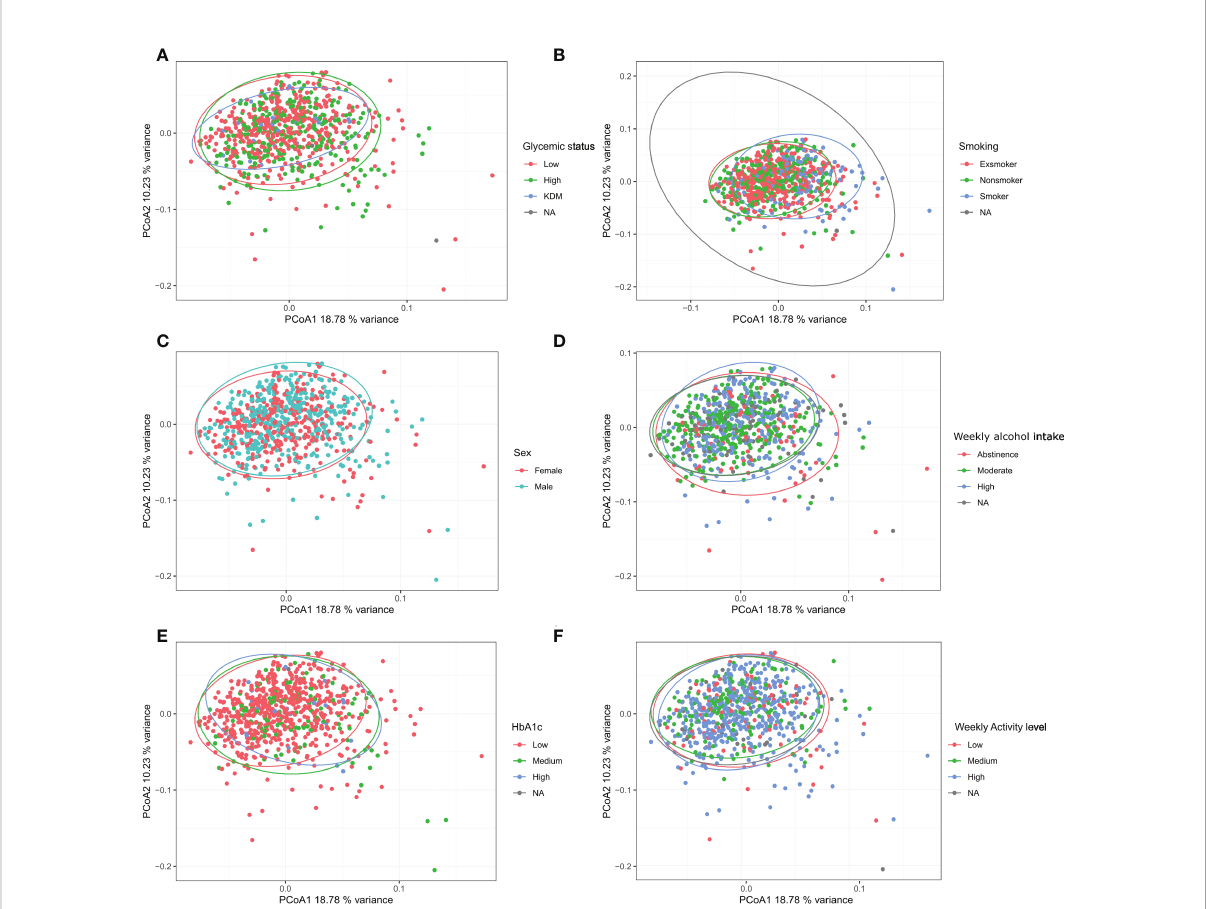
FIGURE 3 Beta diversity: Bray-Curtis dissimilarity calculated from Hellinger transformed total sum scaled data was used as beta-diversity measure and visualized with principal coordinate analysis (PCoA). (A – F) : glycemic status, smoking, sex, weekly alcohol intake, HbA 1c , and weekly activity